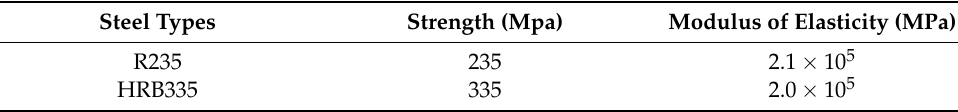
Table 1. The mechanical properties of variously used reinforcements.